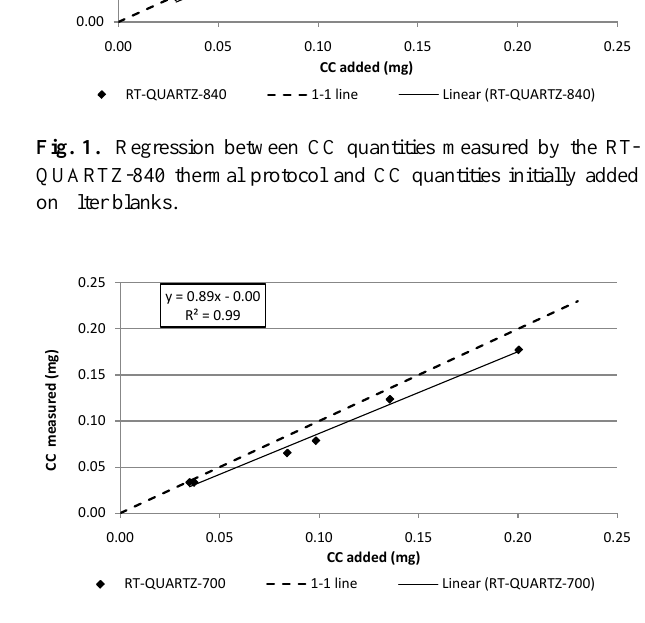
Fig. 2. Regression between CC quantities measured by the RT- QUARTZ-700 thermal protocol and CC quantities initially added on filter